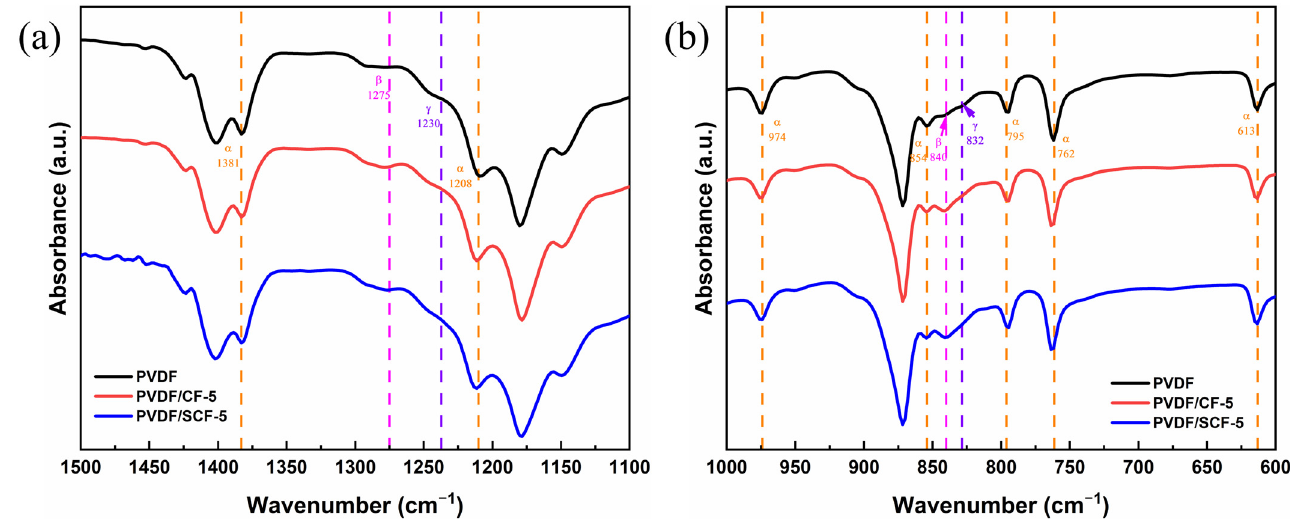
Table 2. Percentage proportions of the α - and β -phase in the PVDF composites.